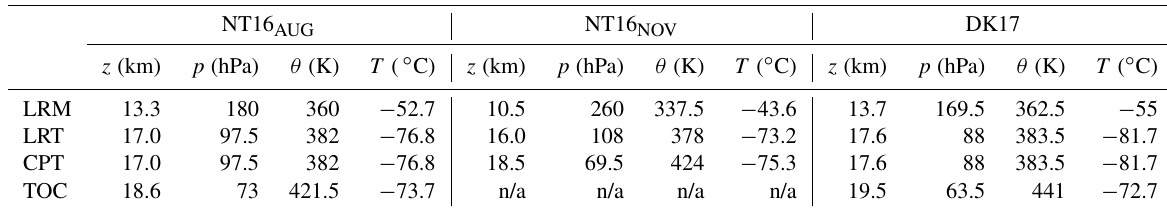
Table 3. Mean values of altitude ( z ), pressure ( p ), potential temperature ( θ ) and temperature ( T ) of the lapse-rate minimum (LRM), lapse- rate tropopause (LRT), cold-point tropopause (CPT) and top of confinement (TOC) levels during the three campaign periods, NT16 AUG , NT16 NOV and